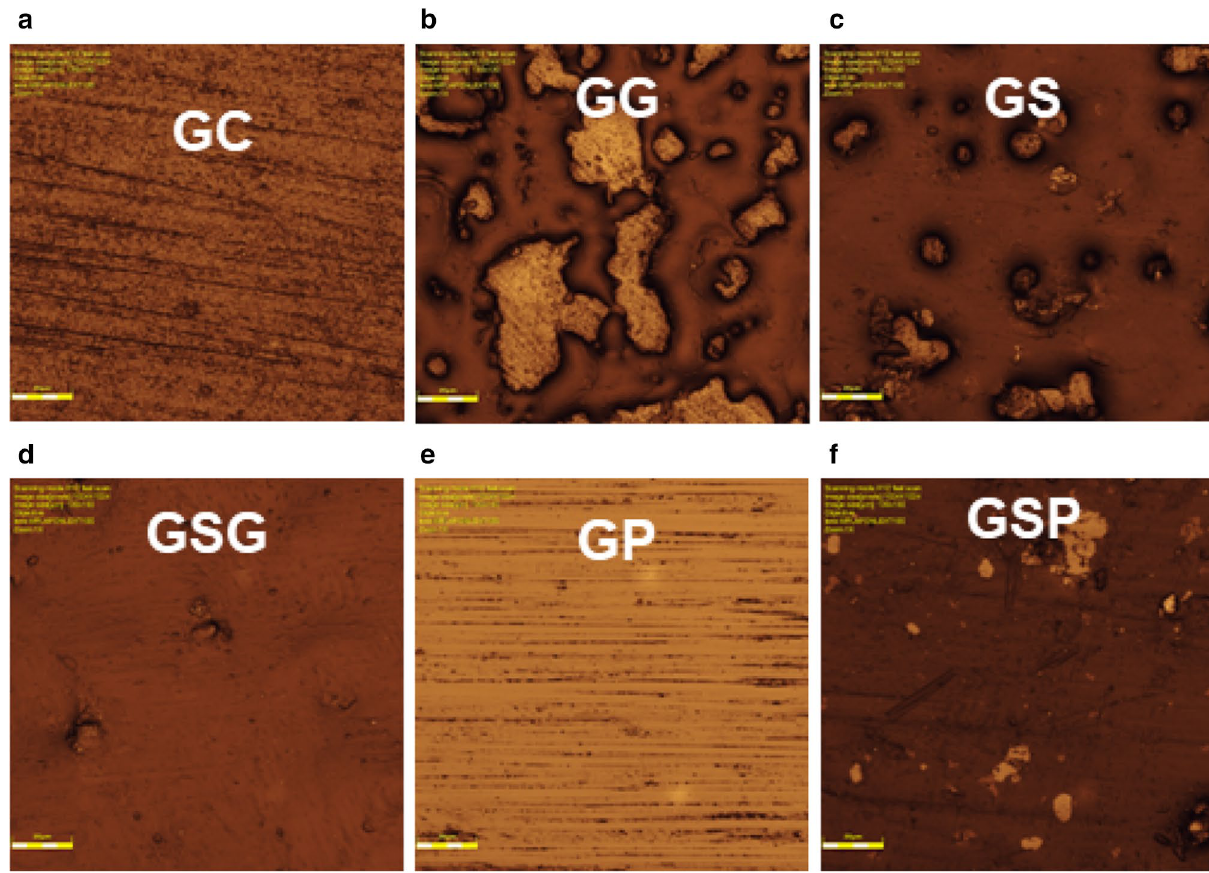
Figure 1. Image captures of the surface morphology of the experimental groups. ( a ) GC (control). ( b ) GG (glazing). ( c ) GS (staining). ( d ) GSG (staining and glazing) ( e ) GP (polishing). ( f ) GSP (staining and